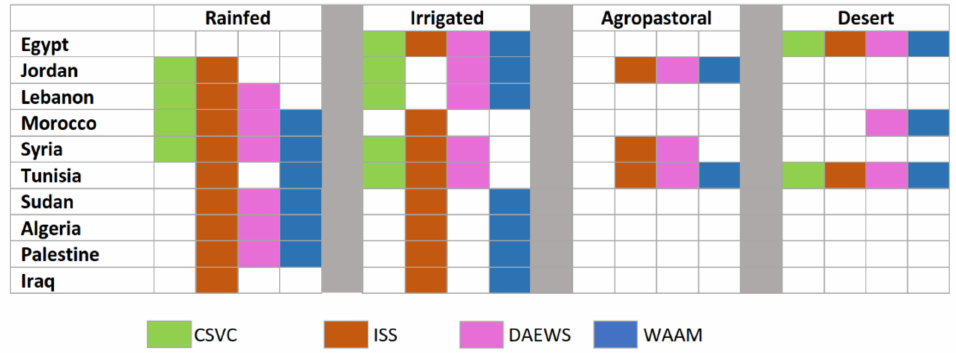
Figure 8. A pictorial representation for implementation of different R4D Lifts in various countries of MENA in different agroecosystems.